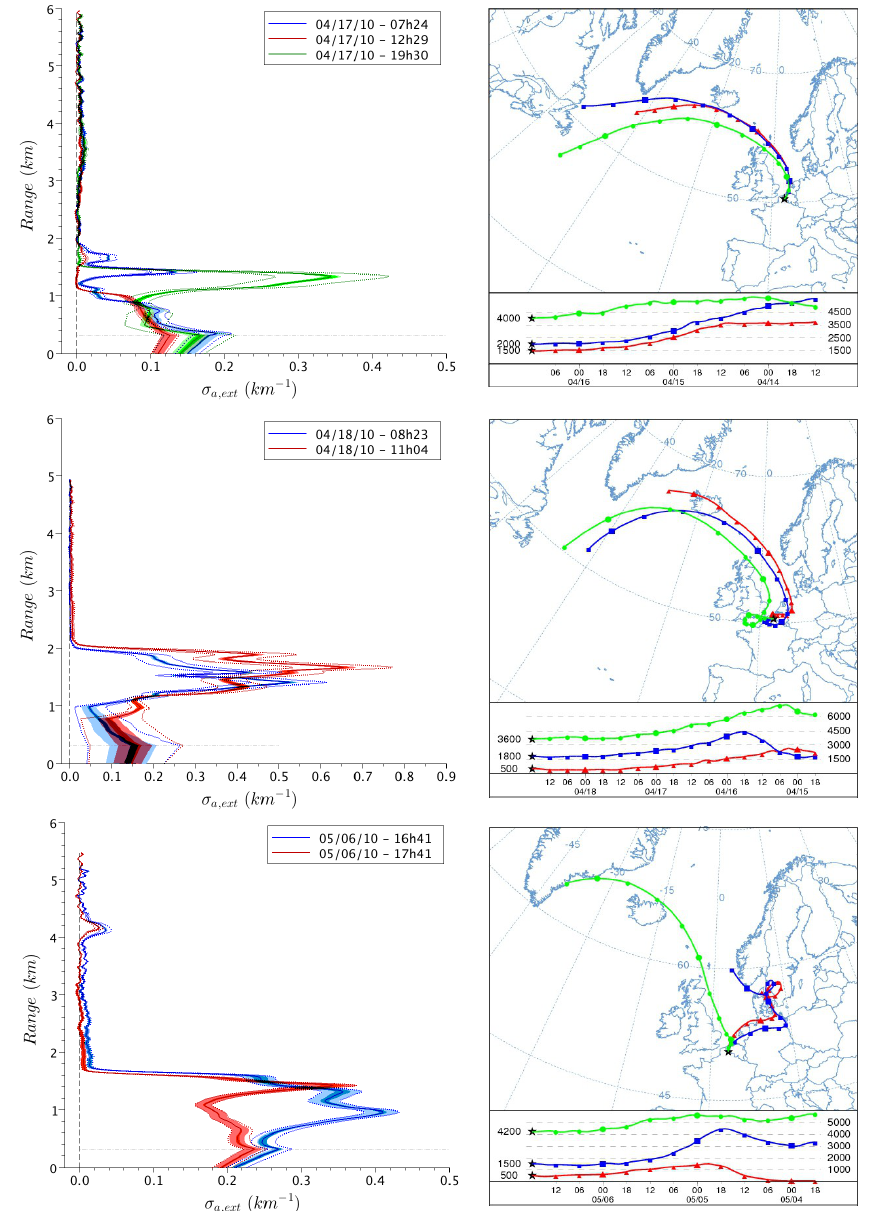
Fig. 6. Retrieved extinction profiles and corresponding backward trajectories for 17, 18 April and 6 May 2010. Colored areas on extinction profiles correspond to uncertainties (light: overlap, dark: noise). Dotted lines are extinction profiles retrieved taking into account the input LR ASH uncertainty